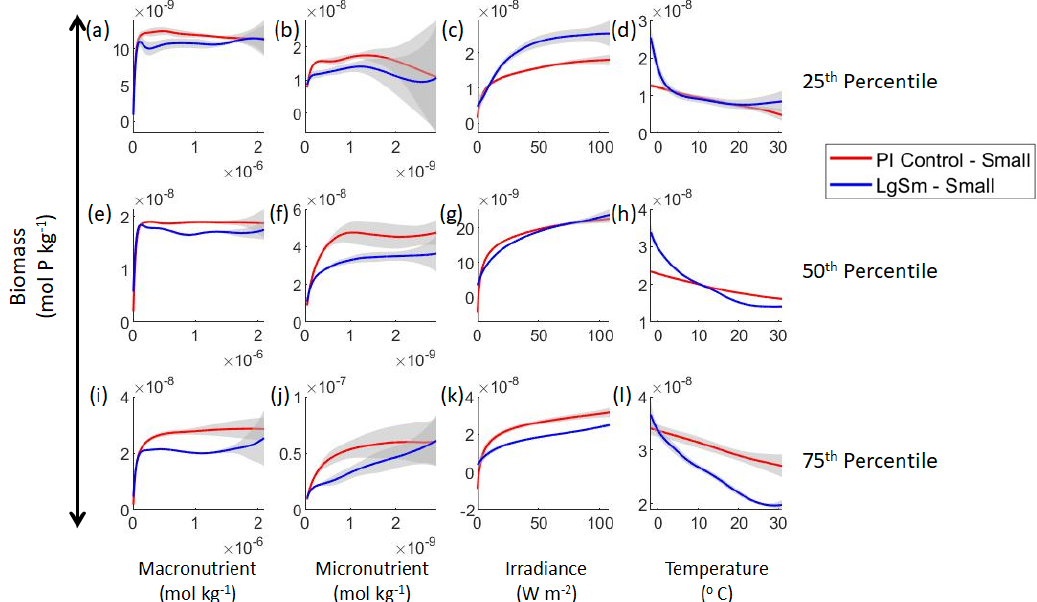
Figure 8. Sensitivity analysis plots for the small phytoplankton of Case 2. This figure is provided to allow for examination of the apparent relationships for the small phytoplankton, since the large phytoplankton apparent relationships made it difficult to see those for the small phytoplankton in Fig. 7. Each line is the prediction for the NNE (i.e., the average prediction of 25 NNs) specific to each model run, and the color of each line represents the model run (PI Control – red; LgSm – blue). The gray region around each line shows 1 standard deviation in the predictions of the individual NNs that make up each NNE (e.g., the gray region around the solid red curves shows the standard deviation in the predictions of the 25 NNs that make up that particular NNE). The rows correspond to the percentile value at which the other predictor variables were held constant (e.g., panel a varies the macronutrient across its min–max range and holds the micronutrient, irradiance, and temperature at their respective 25th percentile values). Columns show the x -axis variables as they vary between their min–max range. The y axis in all panels is the biomass concentration. Note that the biomass scale changes with each